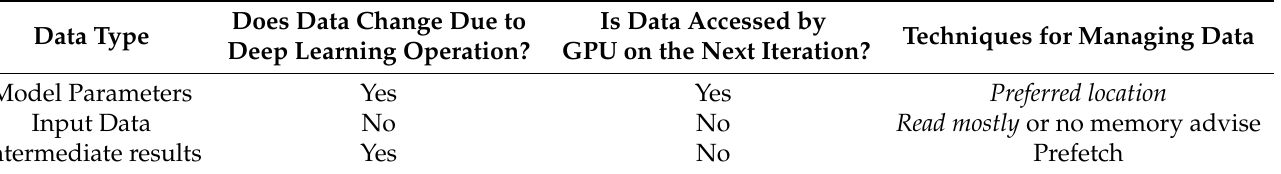
Table 1. Characteristics of deep learning data.